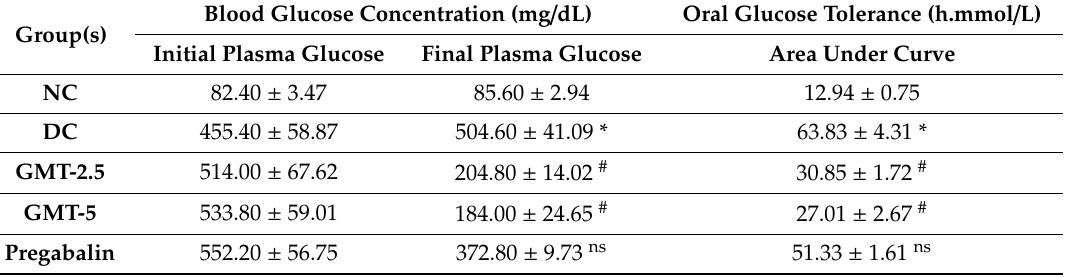
Table 2. E ff ect of chloroform extract of goat milk treated A. napellus on blood glucose level and oral glucose